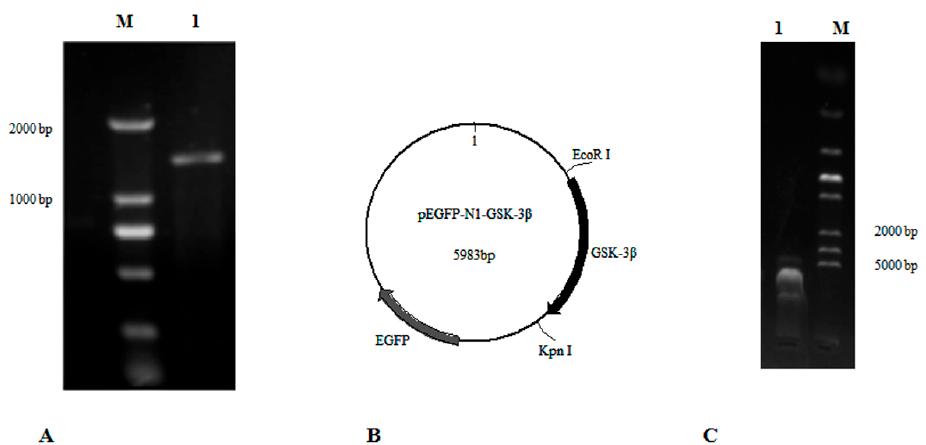
Figure 1. The construction of pEGFP-N1-GSK-3 β . ( A ) The ORF of GSK-3 β was cloned according to primers GSK-3 β -F1 and GSK-3 β -R1. Lane 1, DNA marker; Lane 2, GSK-3 β . ( B ) The map of pEGFP-N1-GSK-3 β . ( C ) The connected fragment of GSK-3 β and pEGFP-N1 was amplified using PCR. Lane 1, the connected fragment of GSK-3 β and pEGFP-N1; Lane 2, DNA